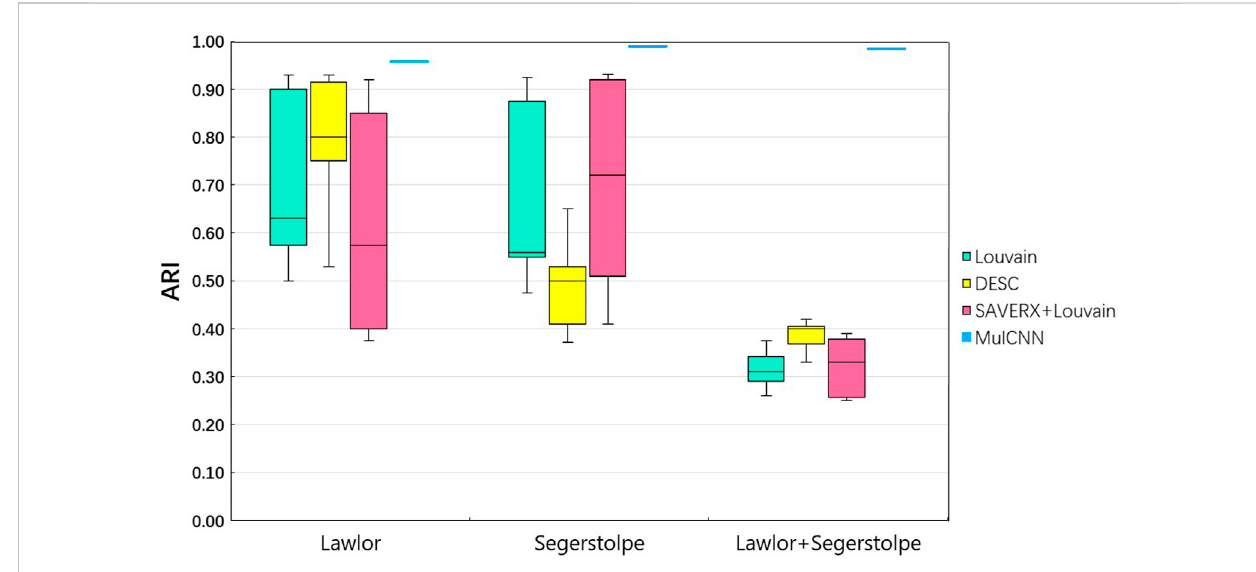
FIGURE 3 ARI analysis of MulCNN compared with other clustering